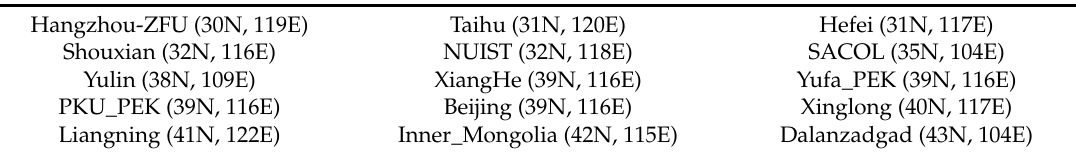
Table 2. Precipitable water observation stations in China.